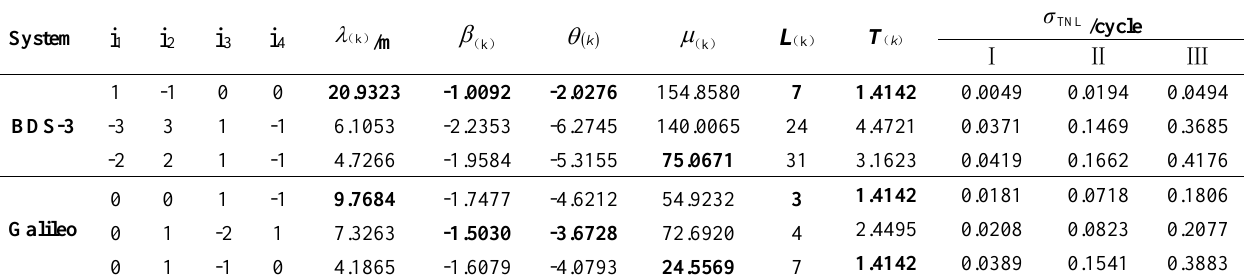
Table 4. Optimal combinations and parameters of four-frequency signals for